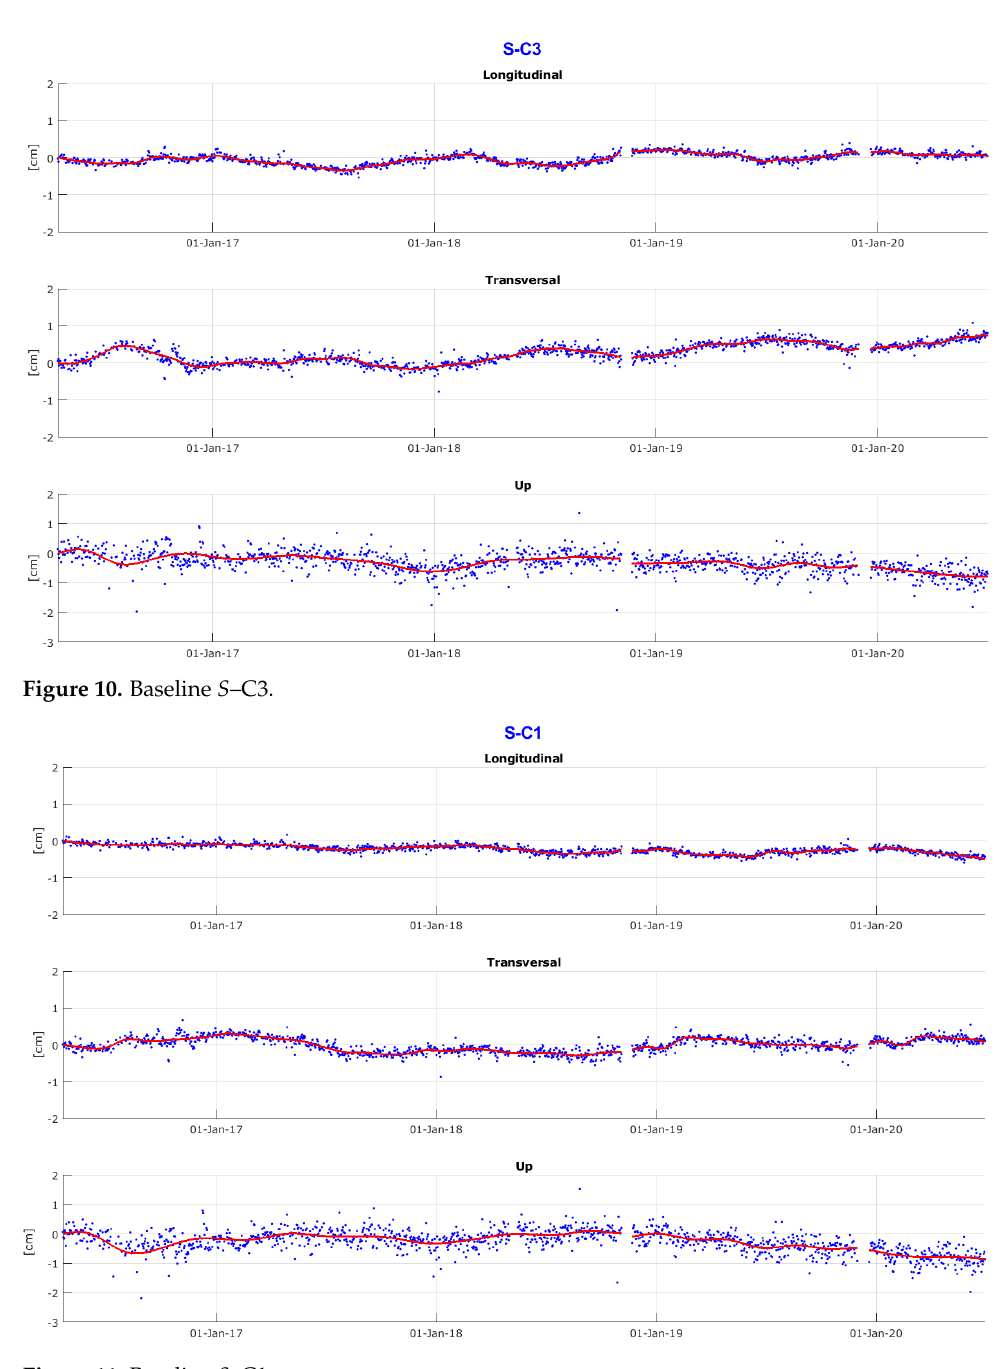
Figure 11. Baseline S